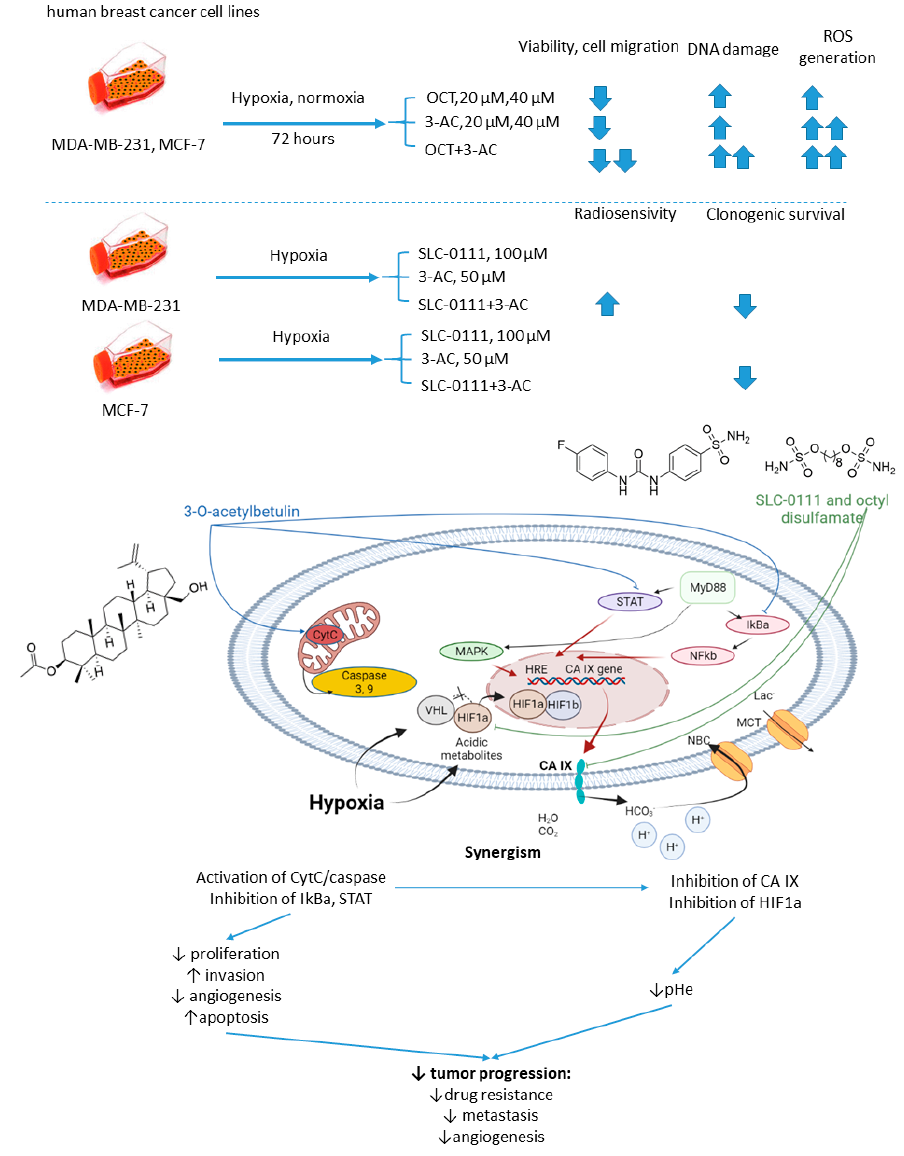
Figure 14. Graphical outline of the study on SLC-0111/OCT+3-AC combination reported by Petrenko et al., and summary on the hypothesized molecular interactions resulting in synergistic action of the drugs [79].